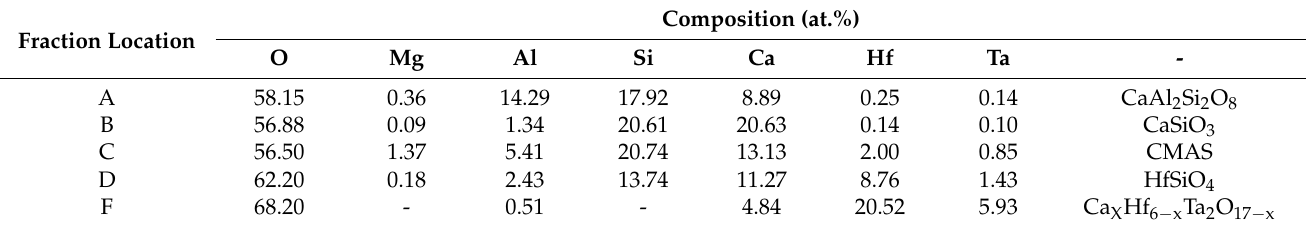
Table 2. Chemical compositions of the marked regions in Figure 6b.